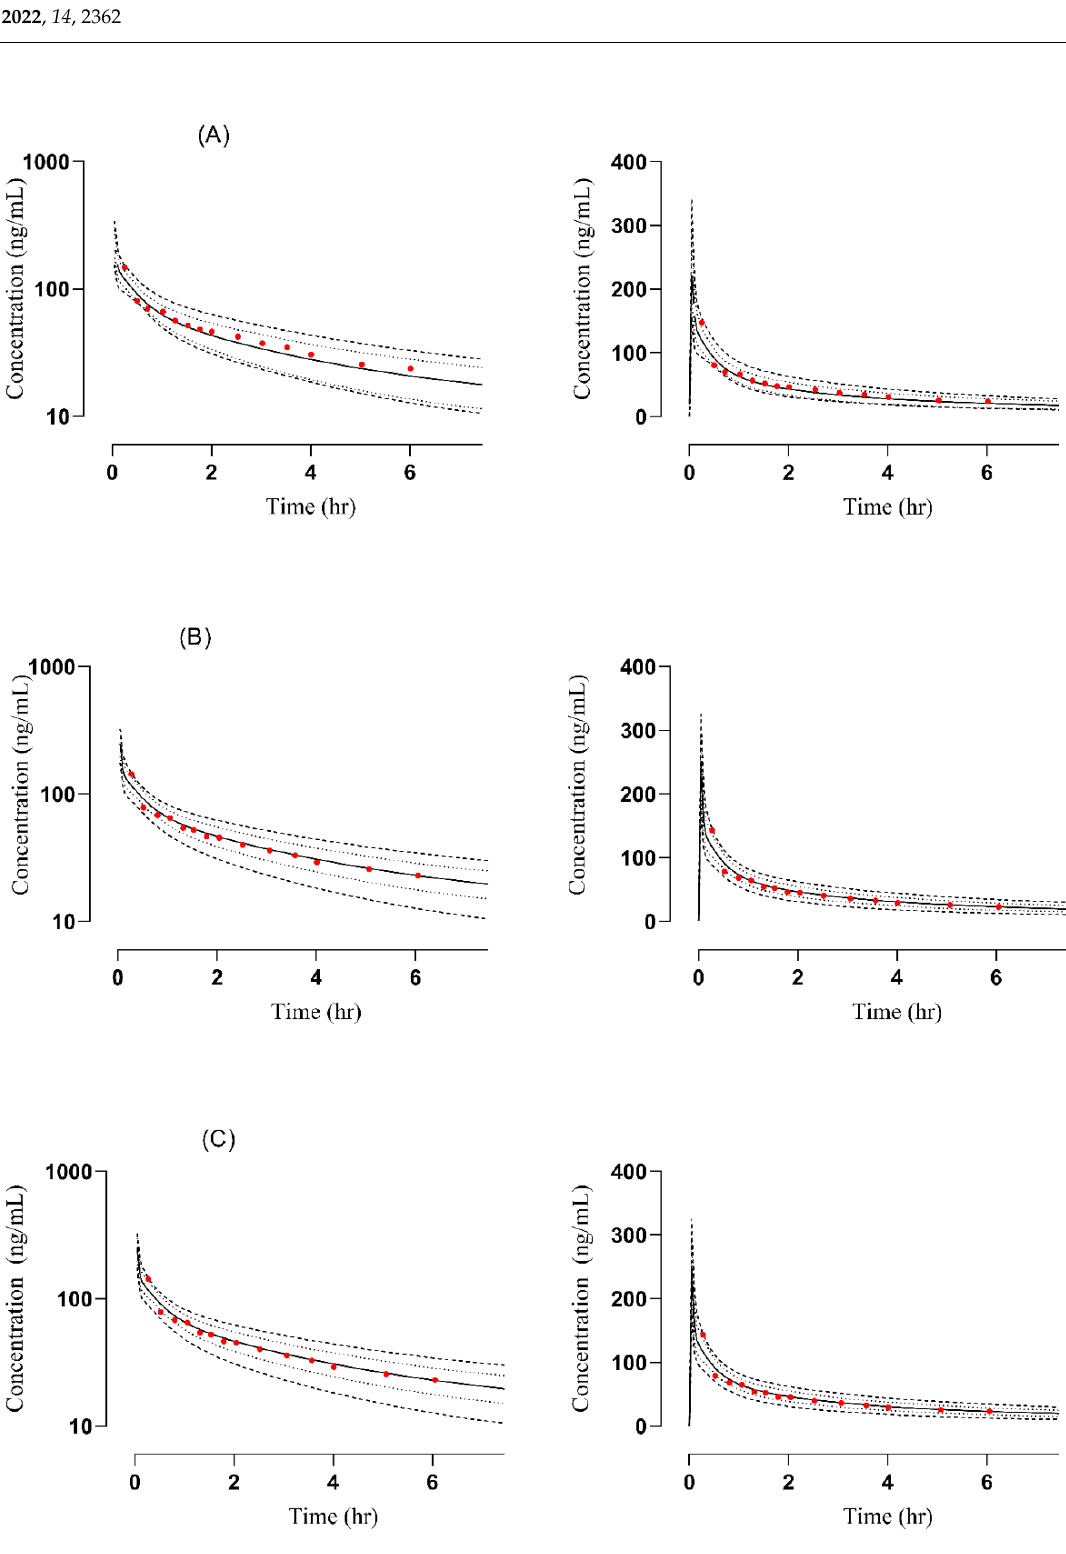
Figure 2. Comparison of observed and predicted plasma concentration versus time profile in healthy subjects after IV administration at a dose of 0.5 mg/kg. ( A ) [24], ( B ) [25]: simulation for labetalol- glutethimide study, ( C ) [25]: simulation for the labetalol-cimetidine study. The solid line [—] indicates the arithmetic mean, dash line [- - - -] maximum and minimum, the dotted line [....] 5th–95th percentile, red dots indicate observed data, and the solid line indicated predicted data.